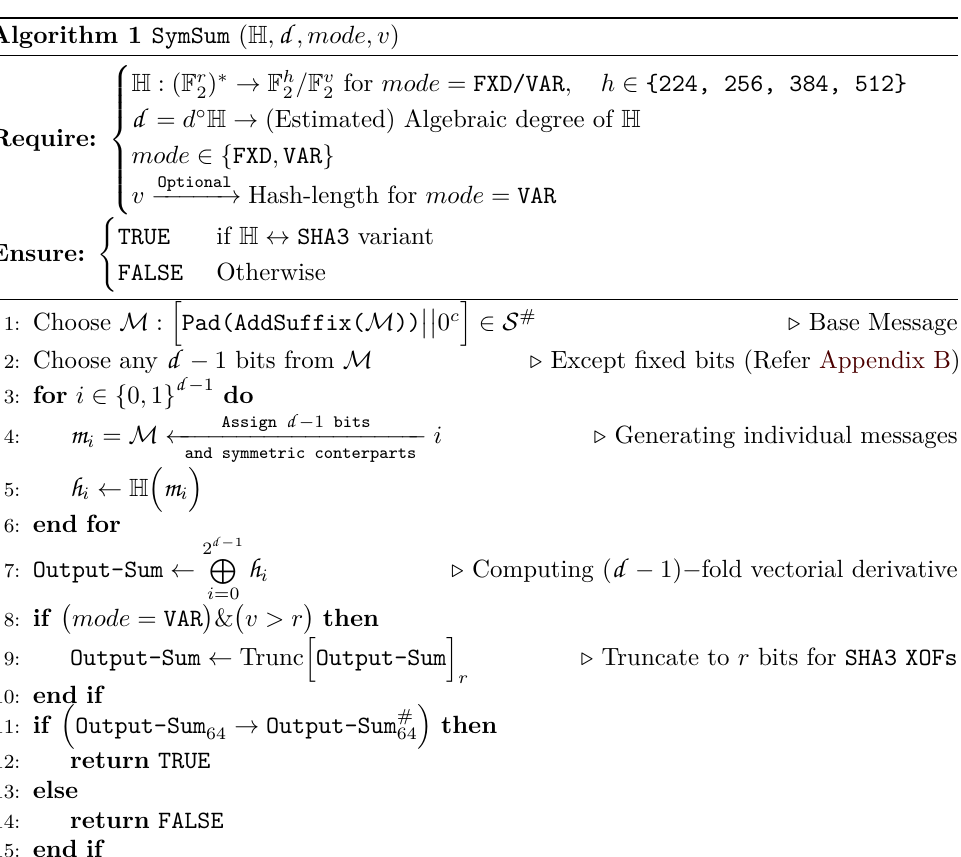
Algorithm 1 SymSum ( H , d , mode, v